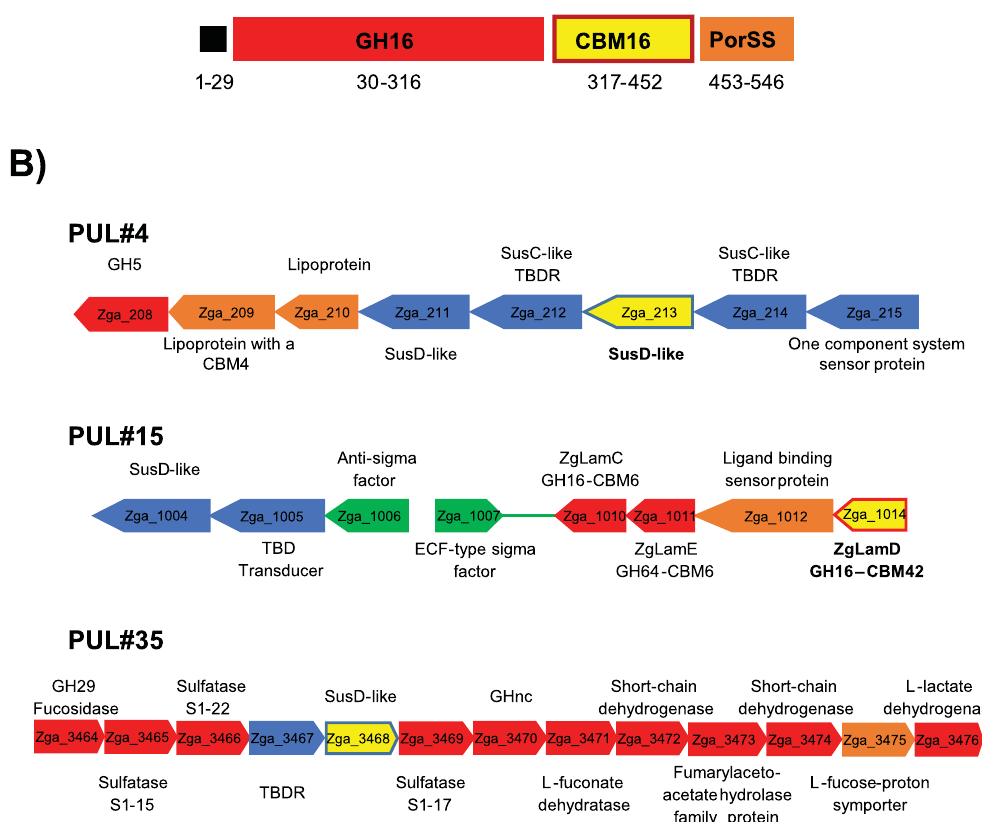
Figure 2. Gene contexts of four selected protein-targets from Zobellia galactanivorans . ( A ) Modular architecture of the kappa-carrageenase CgkA (Zga_236). ( B ) Genetic context of SusD-213, CBM42 and SusD- 3468 in